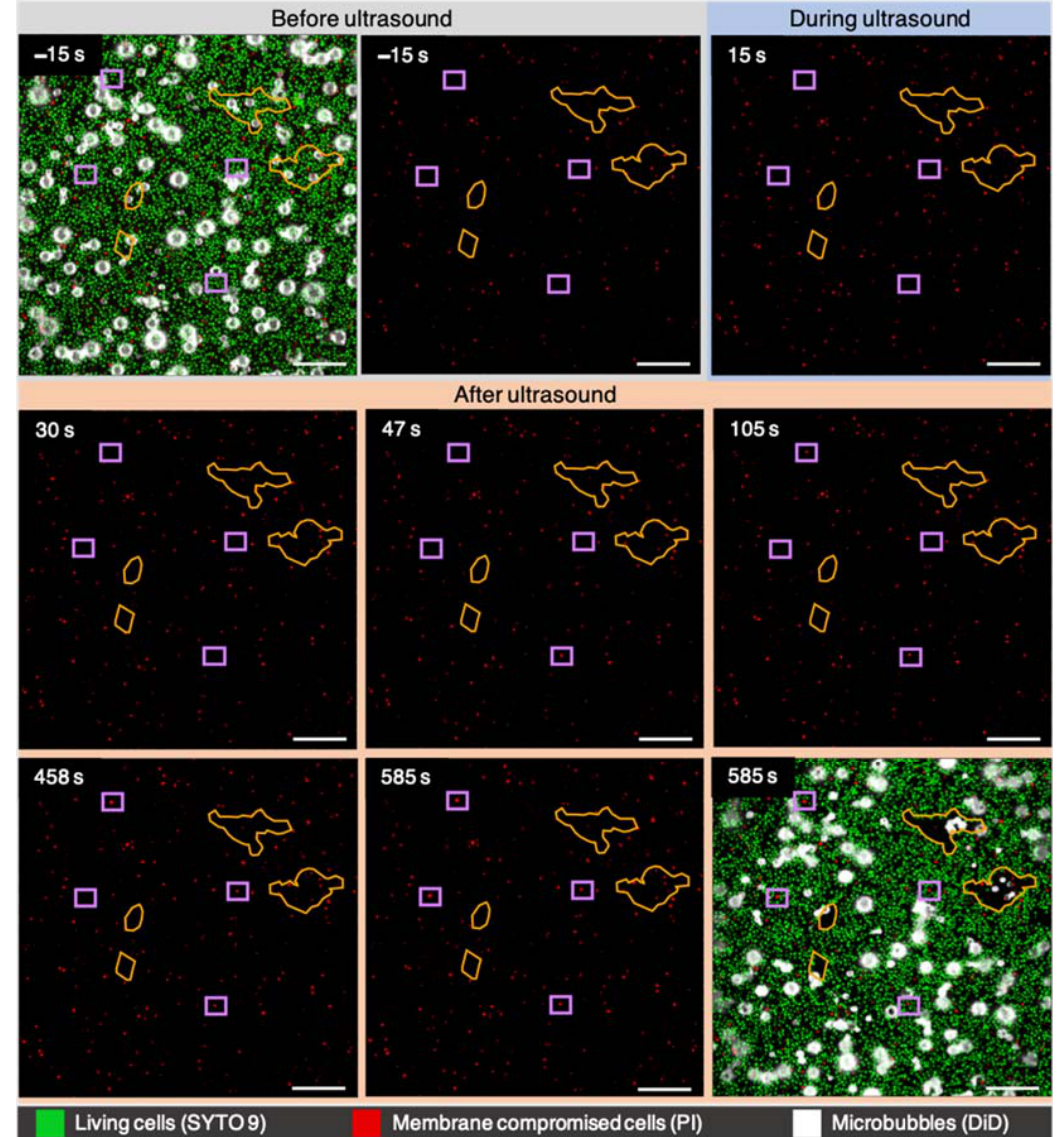
Figure 2. Sonobactericide of S. aureus biofilm at ultrasound settings of 2 MHz, 200 kPa, 100 cycles, PRF 1 Hz, 30 s. Selected confocal microscopy frames during a 10 min time-lapse recording, where the first and last frames are a composite of all three channels, and all others are the PI channel only. Time 0 s is the start of insonification. Purple squares highlight example cells with PI uptake at different timepoints, and orange outlines mark regions of dispersion. Scale bars represent 20 µ